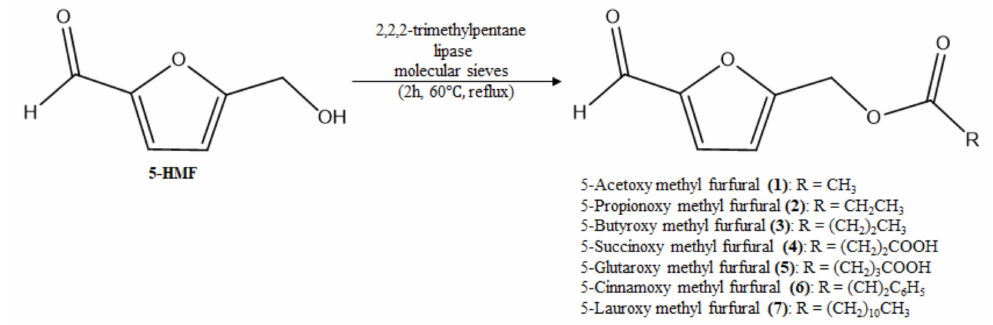
Figure 9. Isolated 5-hydroxymethylfurfural (5-HMF) (HPLC data, NMR spectra and EI-MS data in Supplementary Materials) from Symplocos chinensis f. pilosa Ohwi water extract (SCW) and synthesized